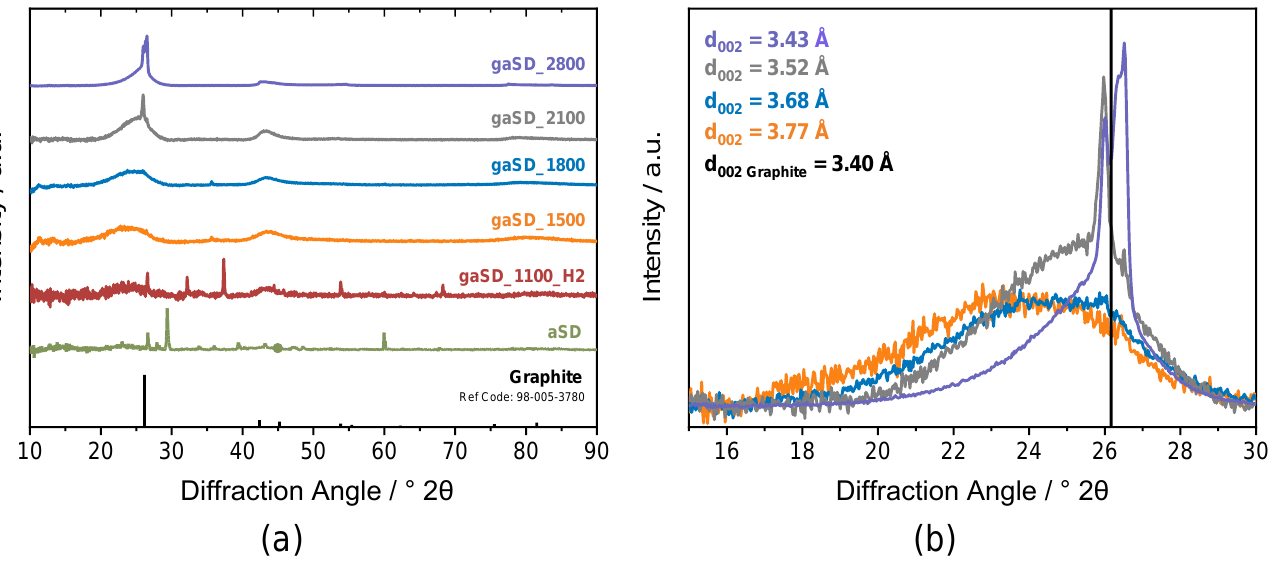
Figure 3. ( a ) PXRD patterns of six different carbons and graphite reference pattern from database (reference code: 98-005-3780) [30] ; ( b ) zoom of diffractogram from 15° to 30° .